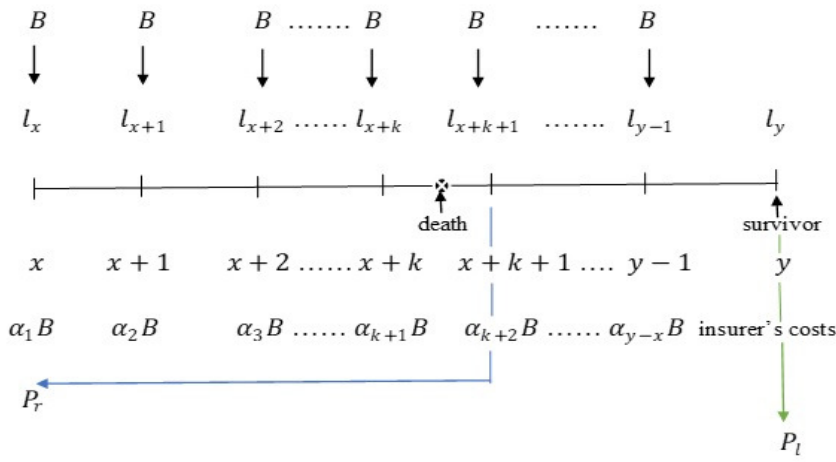
Figure 2. Schematic drawing of the accumulative pension scheme with annual contributions and a lump sum payment on retirement and with the possibility of